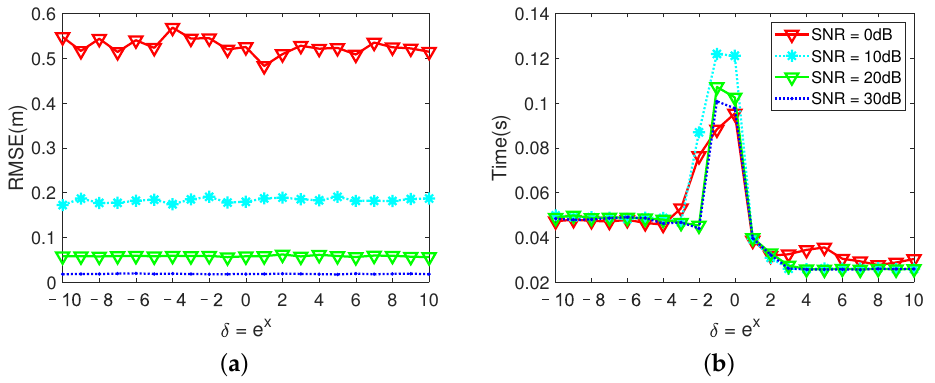
Figure 18. Performance of Tomo-ANM-IVDST under different stepsize δ and SNRs. ( a ) Location accuracy. The legend is the same as in ( b ). ( b ) Time consumption.